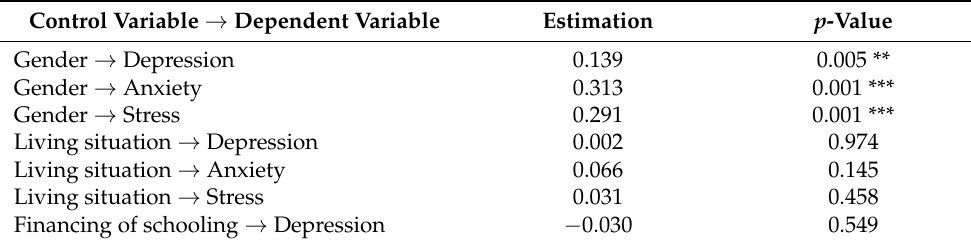
Table 3. Standardized estimates of the effects of control